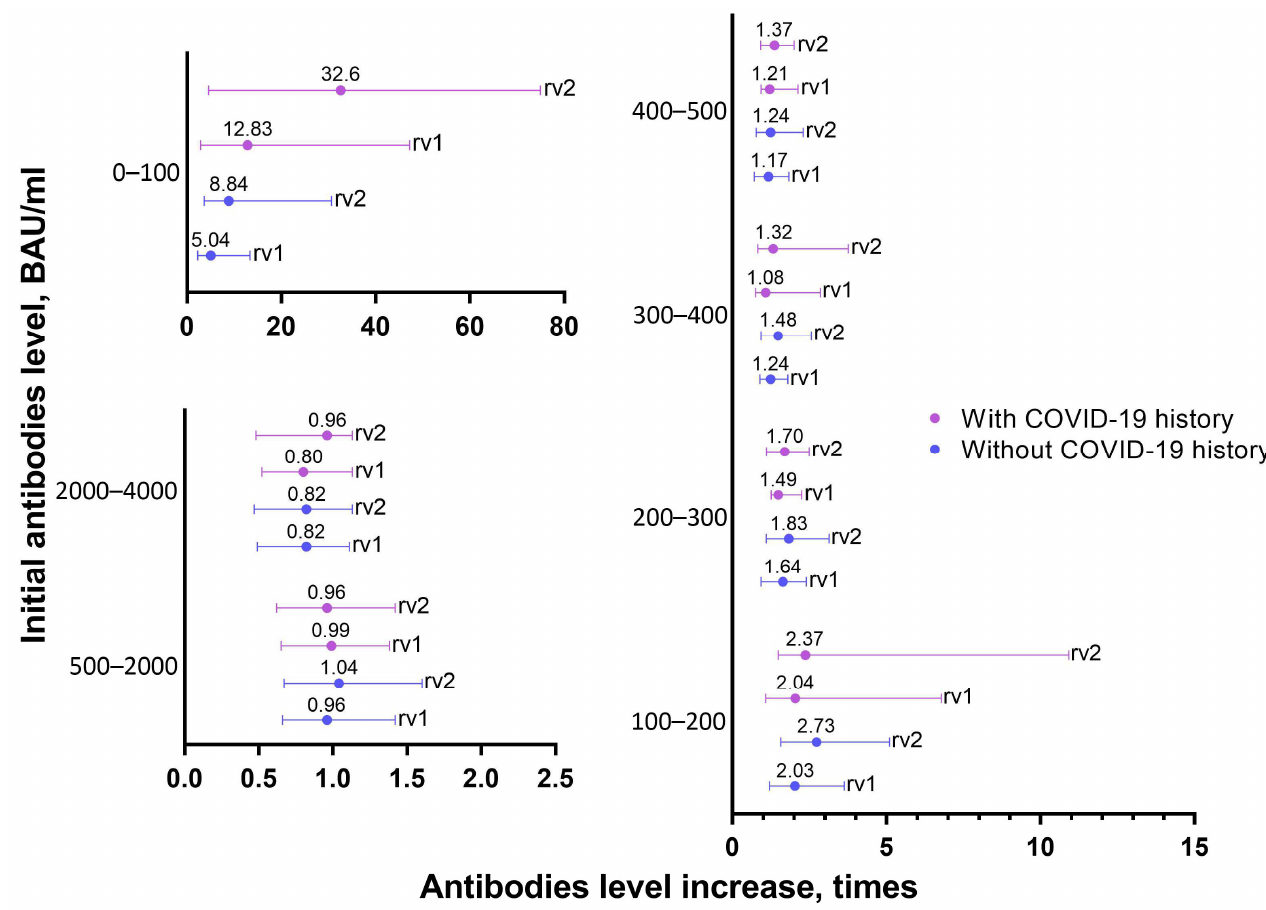
Figure 3. Increasing IgG to RBD level after booster vaccination, depending on the COVID-19 contrac- tion in the anamnesis. In the figure, the marker shows the median of the antibodies ratio (the ratio of the antibody titer after the introduction of the first or second component of revaccination to the antibody titer before revaccination), and the whiskers show the interquartile range. The values above the graph show the level of antibodies before revaccination .